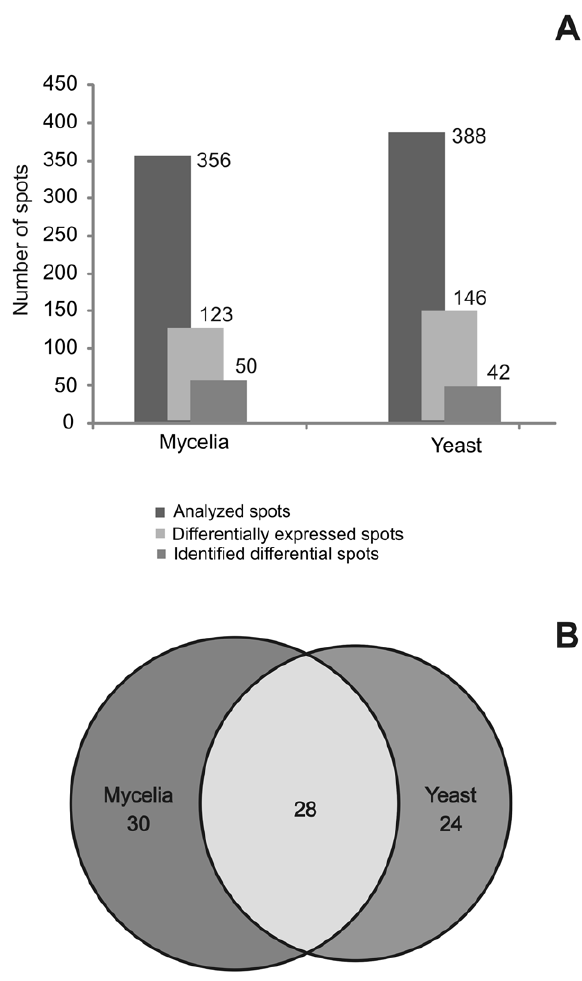
Figure 3. Graphic summation of proteomics analysis. A- The comparative analysis using Image master 2D Platinum software displays the analyzed spots and the preferentially expressed spots in mycelia and yeast secretomes, while the mass spectrometry analyses displays the identified differentially expressed spots. B- The Venn diagram shows the number of identified proteins via MS/MS. The preferentially secreted extracellular proteins include those with statistically significant alteration in the mycelia and yeast secretome, while the constitutive proteins refer to those with similar expression patterns.